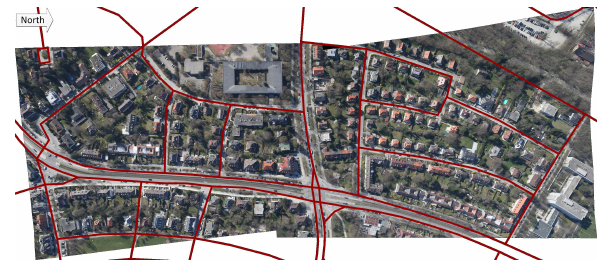
Figure 3. Road axes mapped into a georeferenced image